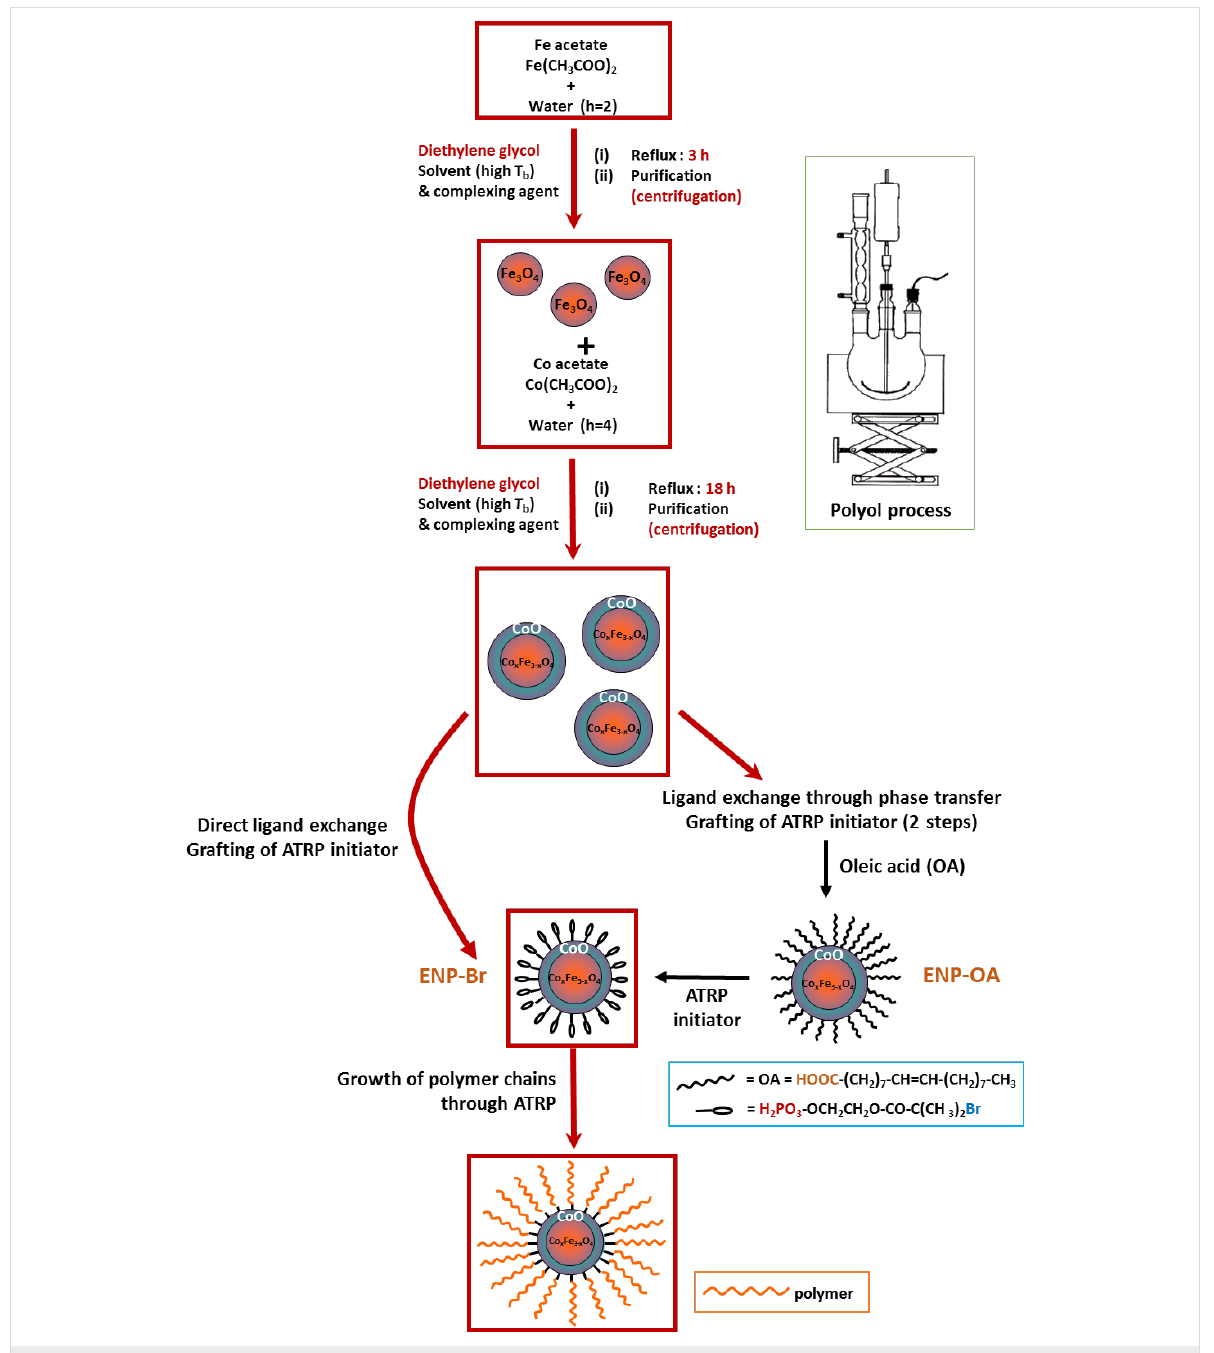
Figure 1: Polymer-decorated exchange-biased Co x Fe 3 − x O 4 @CoO magnetic nanoparticles synthesis.